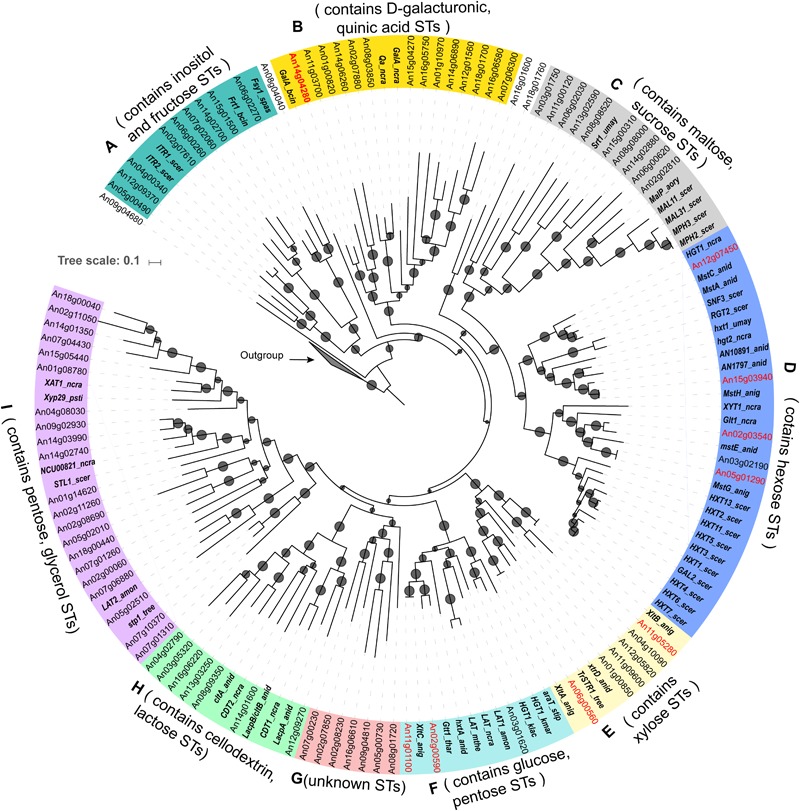
Phylogenetic classification of (putative) sugar transporters in Aspergillus niger. The tree contains 86 sugar transporters of A. niger containing Pfam domain PF00083 and 61 experimentally characterized fungal sugar transporters. The gene names of previously experimental characterized sugar transporters of A. niger are highlighted with red fonts and the literature reported transporters from other fungi species are highlighted with bold italic fonts. Potential substrates for members of each clade are suggested based on the functions of the known transporters included in the specific clades. Arabidopsis thaliana sugar transporters (Buttner, 2010) were used as an outgroup. Branches with bootstrap values >60% were indicated with small circles. The abbreviation of fungal species name is attached to each known transporter gene (anid = Aspergillus nidulans, anig = Aspergillus niger, aory = Aspergillus oryzae, amon = Ambrosiozyma monospora, bcin = Botrytis cinerea, kmar = Kluyveromyces marxianus, klac = Kluyveromyces lactis, ncra = Neurospora crassa, psti = Pichia stipitis, scer = Saccharomyces cerevisiae, spas = Saccharomyces pastorianus, stip = Scheffersomyces stipitis, tree = Trichoderma reesei, thar = Trichoderma harzianum, umay = Ustilago maydis).